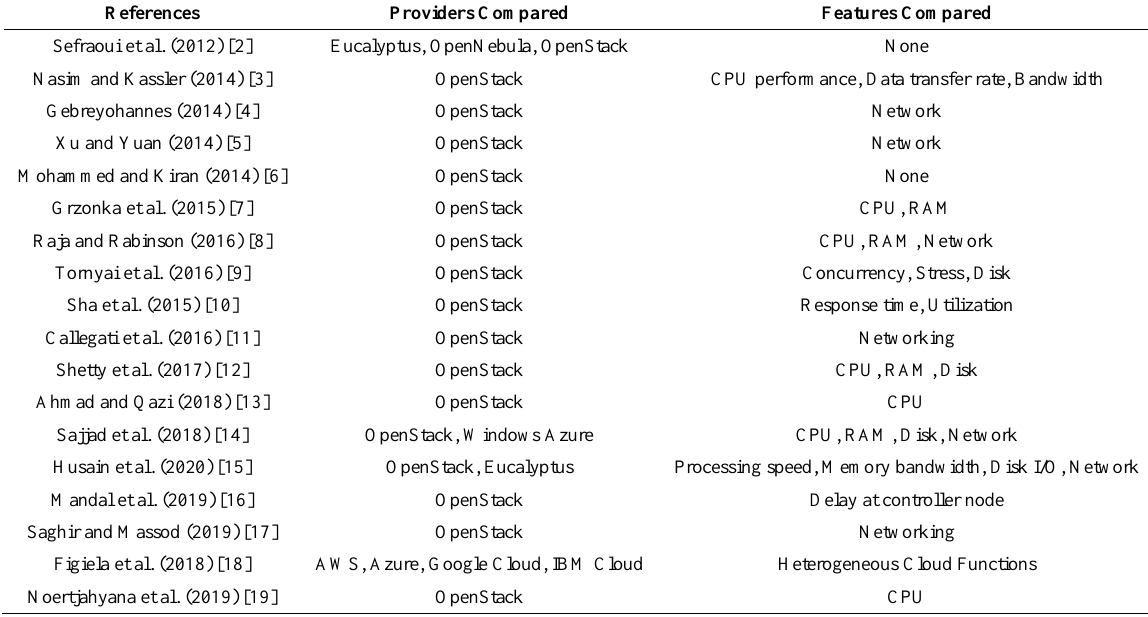
Table 1. Comparison of existing cases in